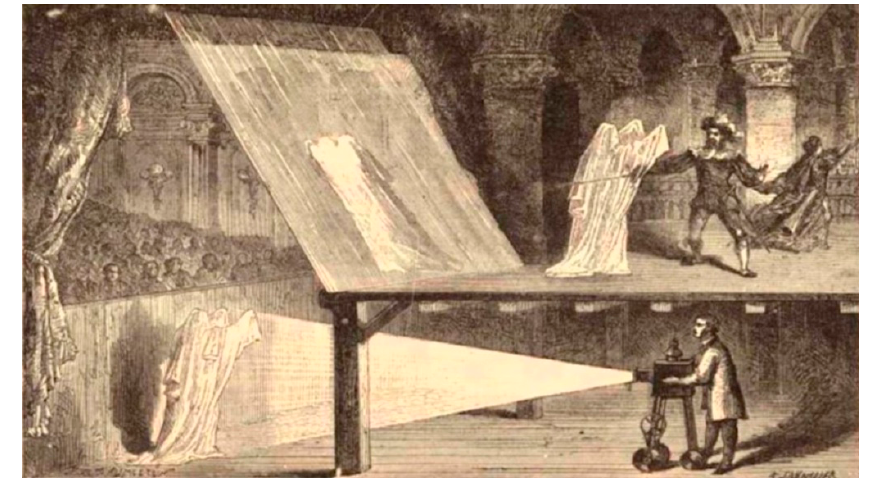
Figure 2. Illustration from “Magasin Pittoresque” 1869 of a Pepper’s Ghost in a French cabaret.